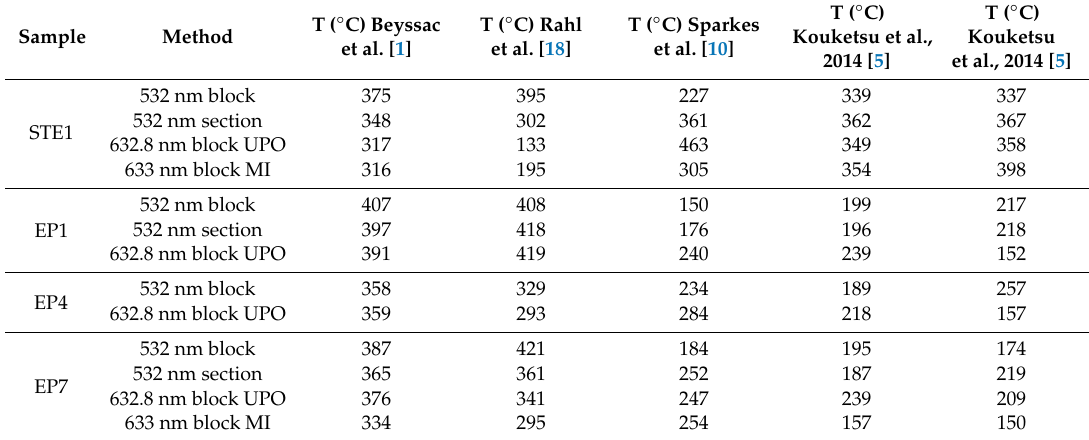
Table 3. Mean temperatures estimated with the five equations for STE1 and EP samples.